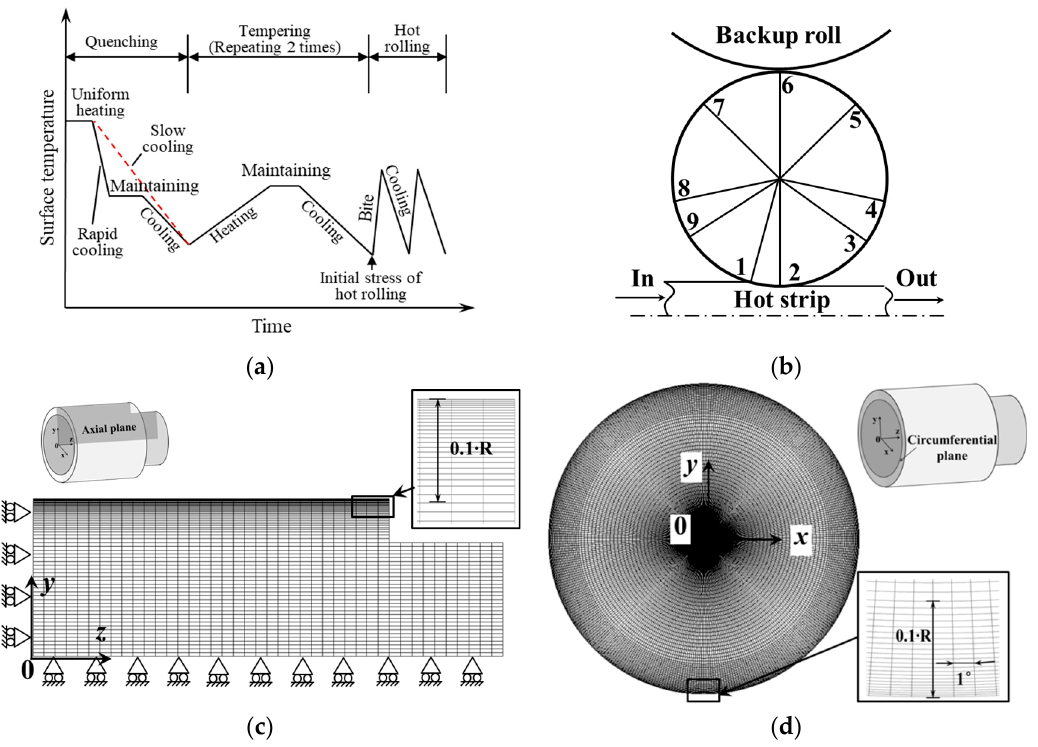
Figure 1. FEM model of the HSS work roll: ( a ) surface temperature during heat treatment and hot rolling; ( b ) thermal boundary conditions during hot rolling; ( c ) FEM model and boundary conditions in the axial plane; ( d ) FEM model in the circumferential plane.